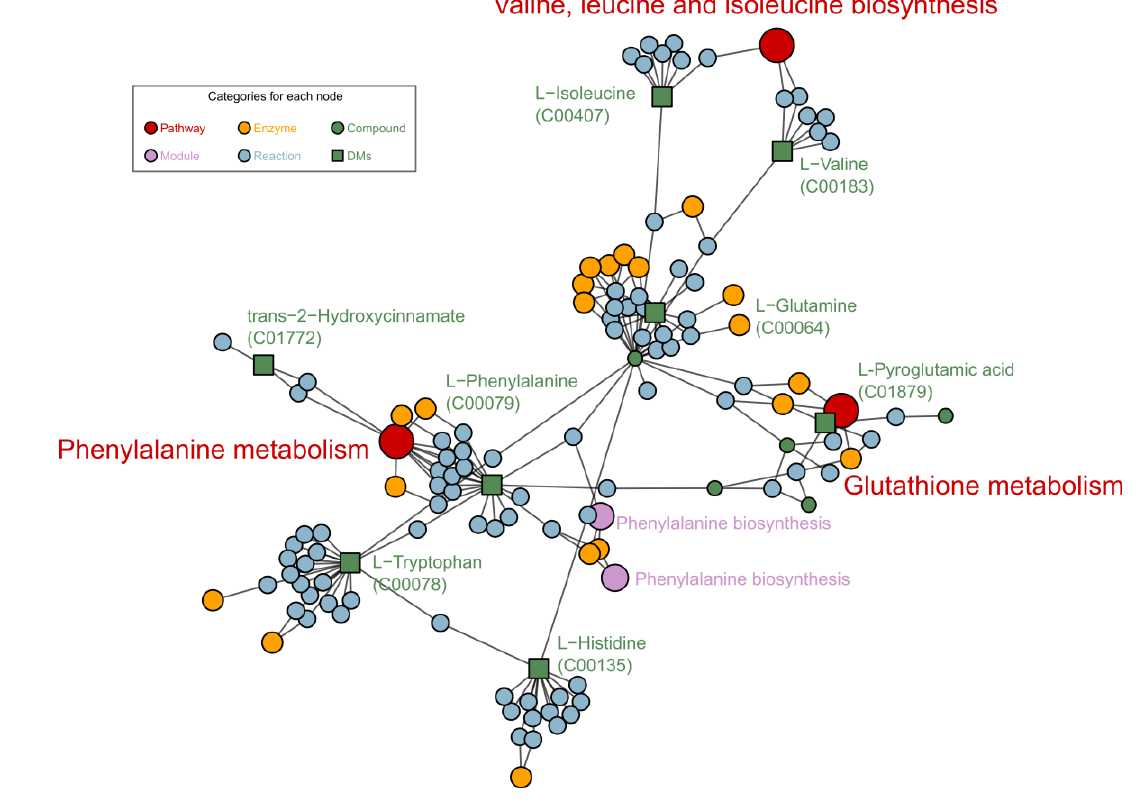
Figure 6. Metabolic pathways generated by FELLA, enriched based on KEGG sly data.